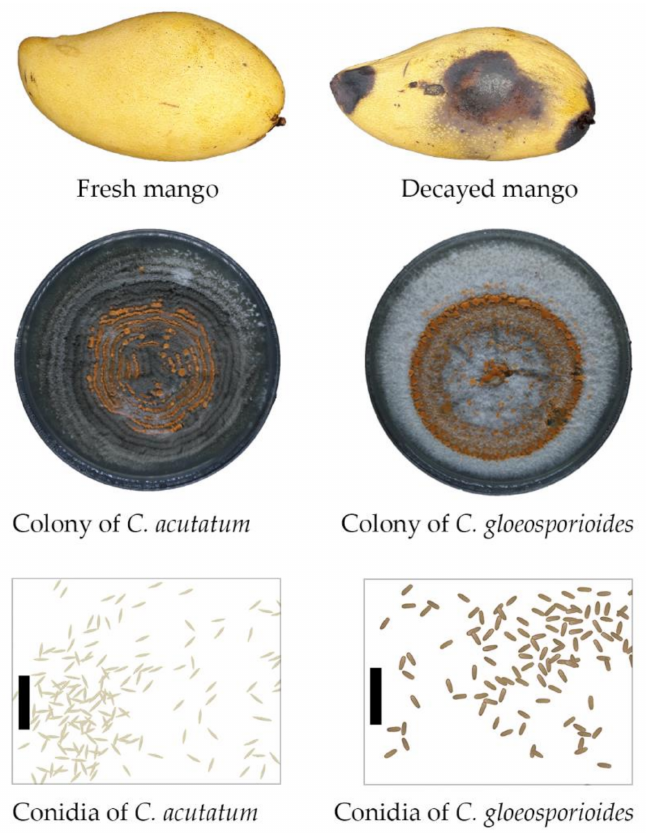
Figure 2. C. acutatum and C. gloeosporioides isolated from the decayed mangoes and their respective colonies and conidia. Bar = 10 µ